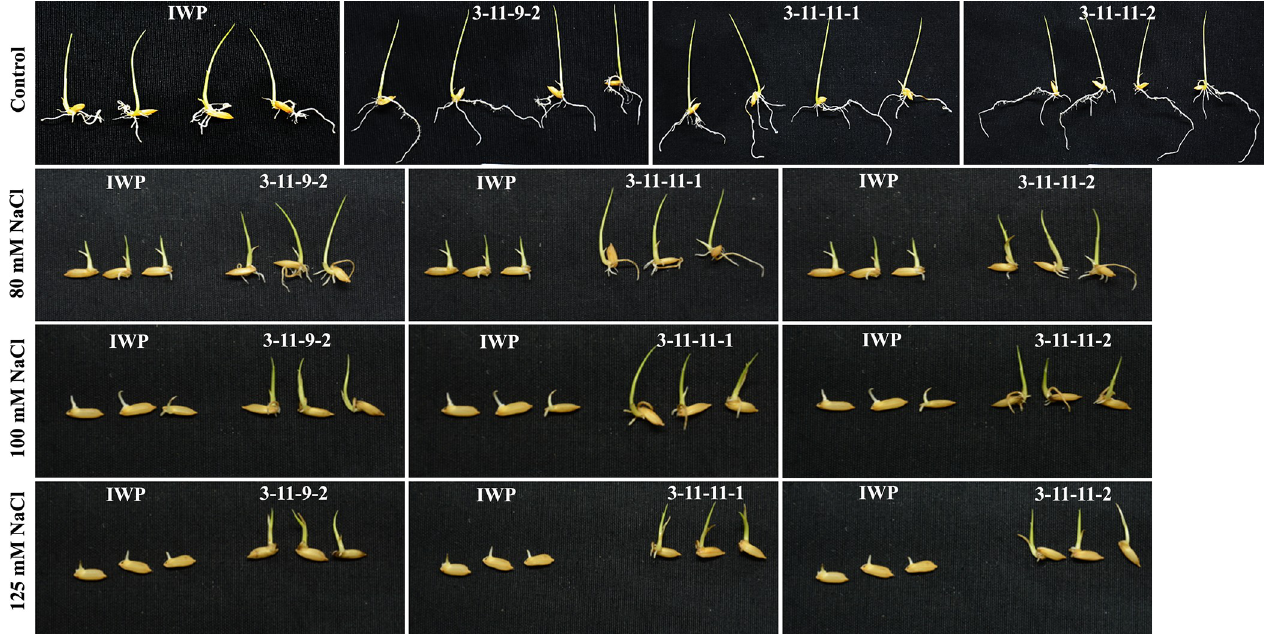
Fig 5. Performance of BILs and IWP under different levels of salinity during germination.